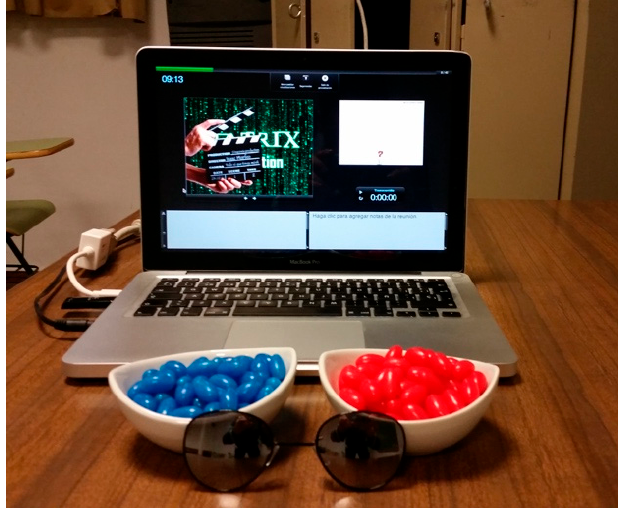
Figure 1. Image of the pills that determine the decision of the students.